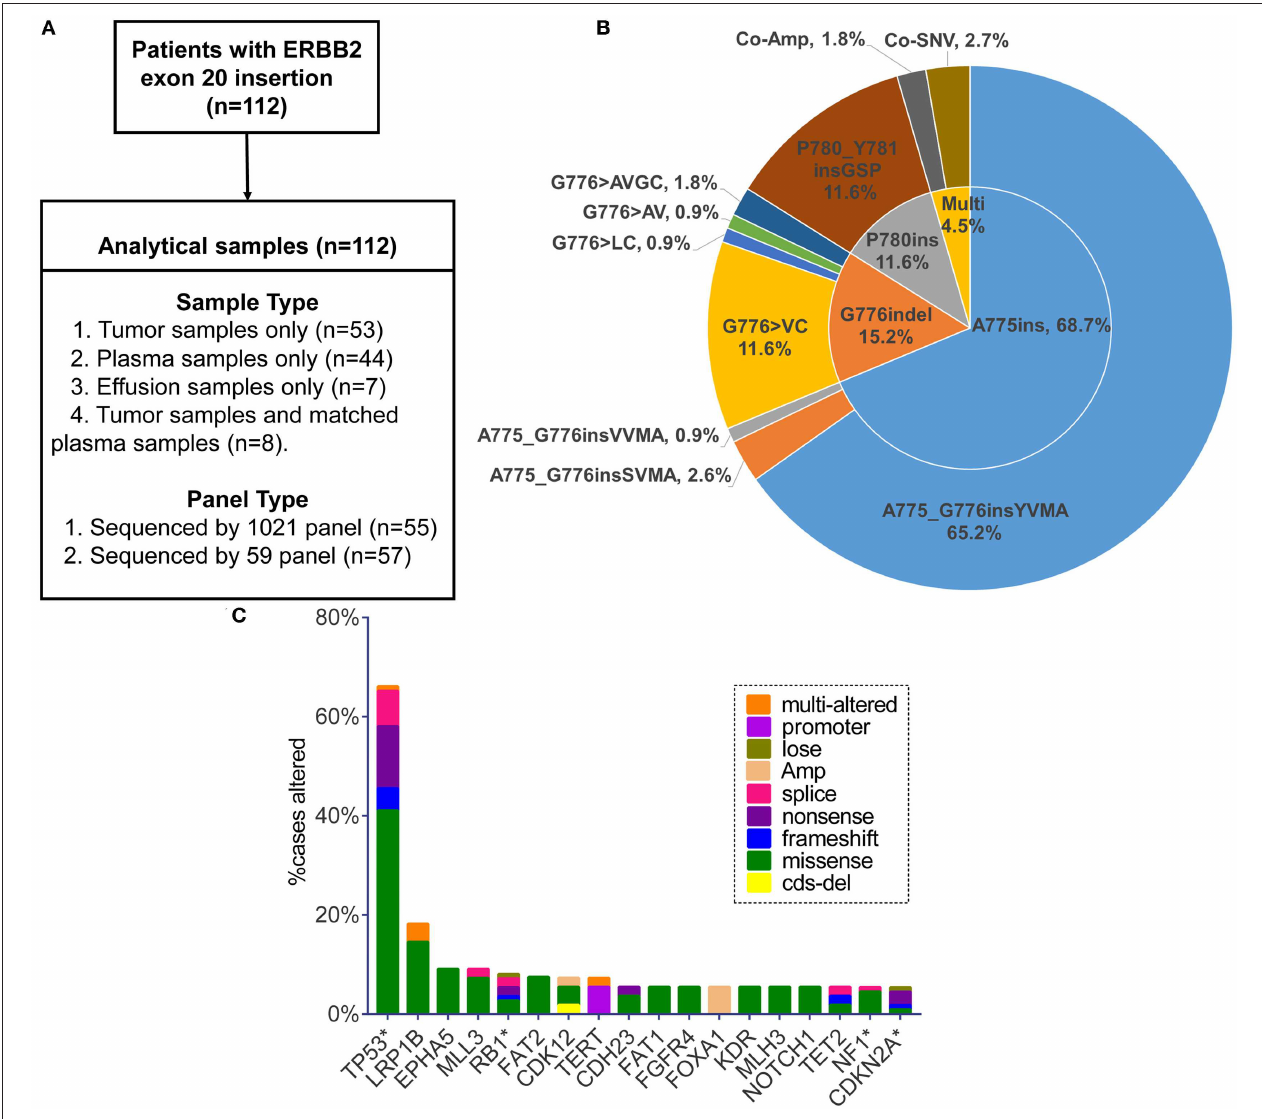
FIGURE 1 | (A) Sample types and sequencing panel details of study design. (B) Pie chart visualizing eight specified insertion subtypes combined with insertion site. Multi, multiple alterations; Co-Amp, co-amplification; Co-SNV, co-single nucleotide variant. (C) Top 18 genes in the highest co-occurring frequency with ERBB2 exon 20 insertion (no relation to the total numbers analyzed). Only the genes with concurrent frequency over 5% are shown. *The genes included in the 59-gene panel.